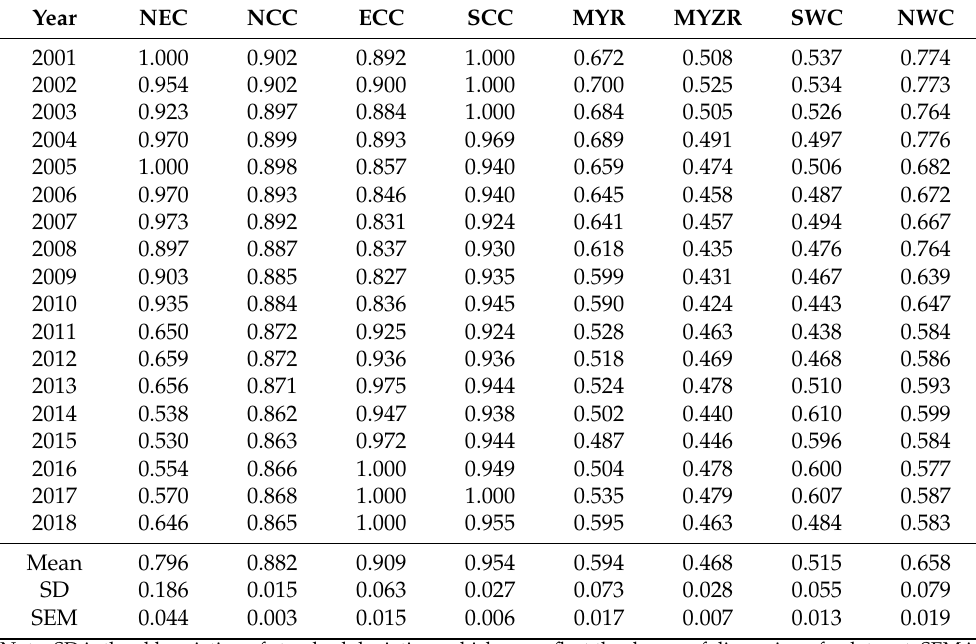
Table 2. PM2.5 environmental efficiency values across the eight regions